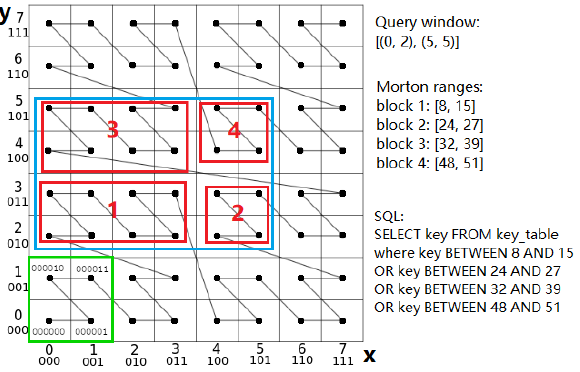
Figure 1. Mapping a 2D window to 1D Morton